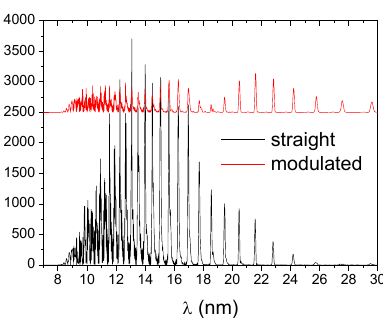
Fig. 6 Far field power spectra for the straight (black) and modulated (red) fiber. For better visibility the later is shifted on vertical axis, but (arbitrary) units are the